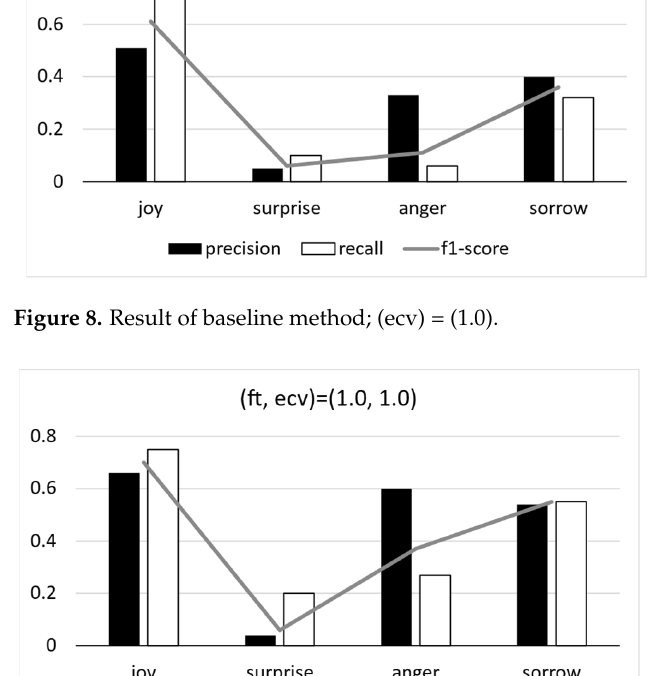
Figure 9. Result of baseline method; (ecv) = (1.0).